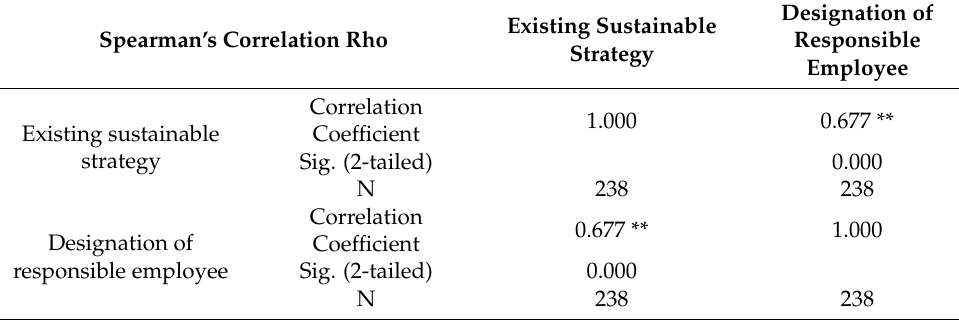
Table 7. Evaluation of RH1 (own elaboration, 2021).